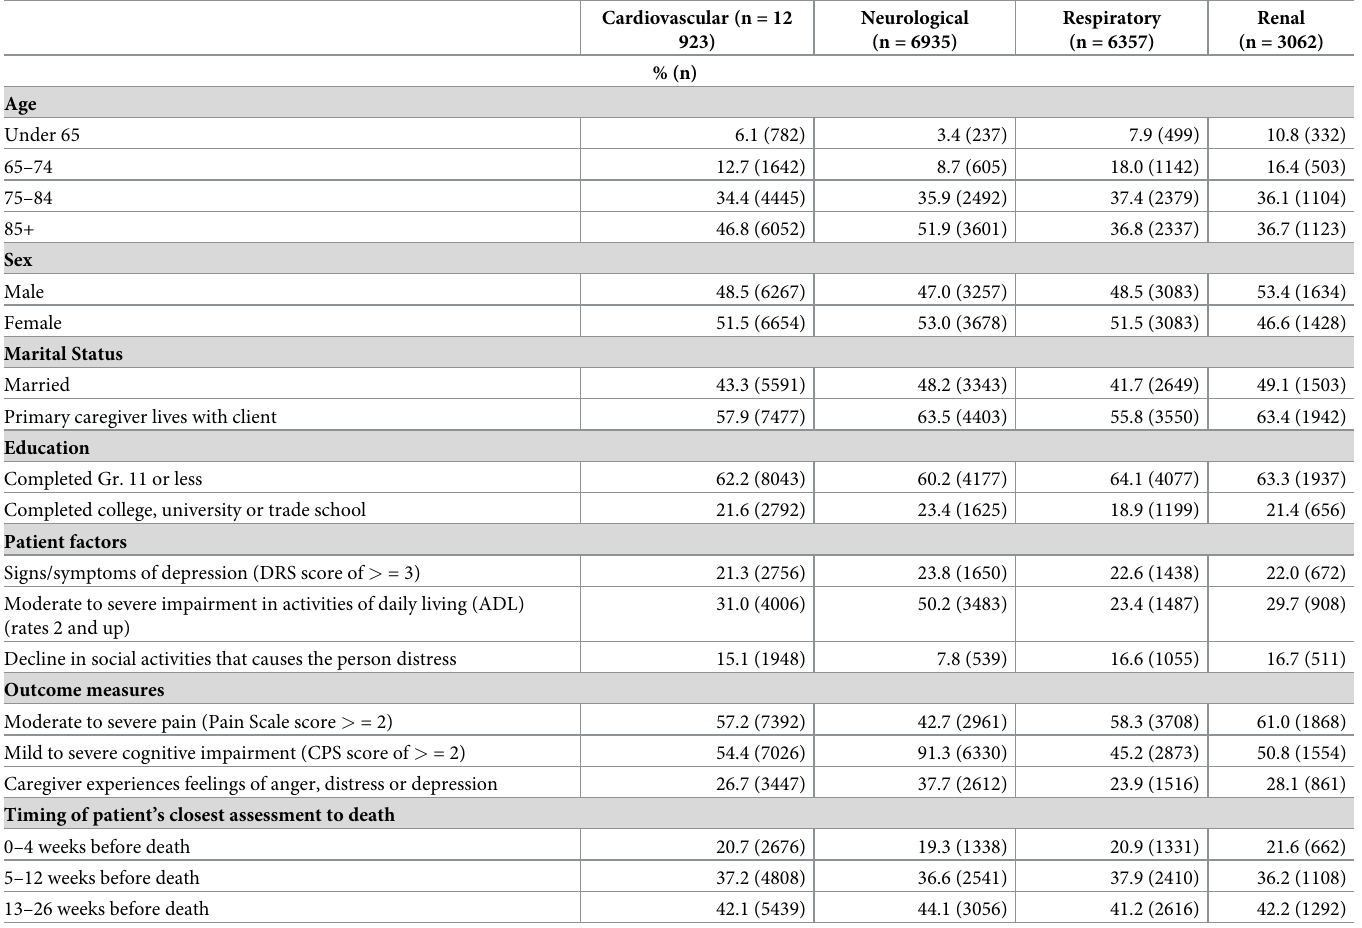
Table 1. Characteristics and overall symptom burden by disease